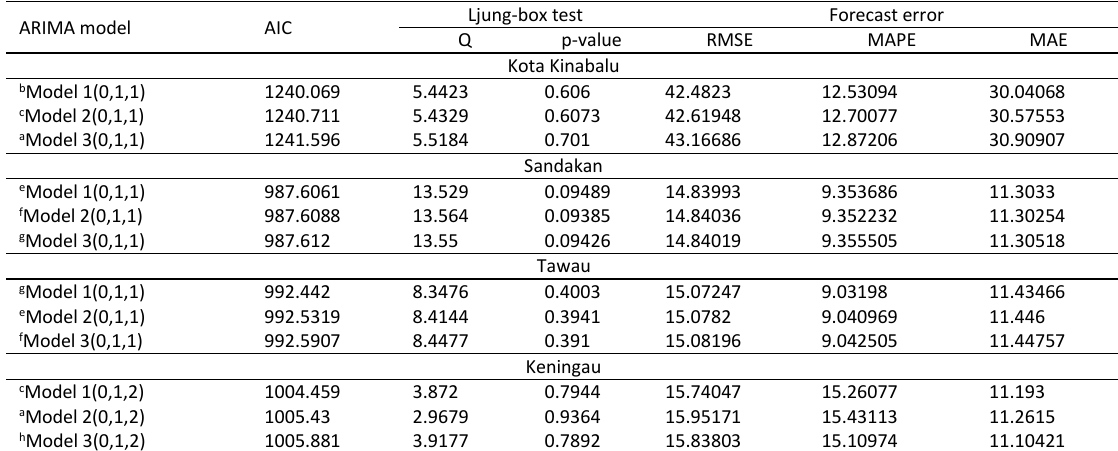
Table 4: ARIMA model for cardiovascular hospital admission in Sabah 2010–2019 with air pollutants as the regressor Ljung-box test Forecast error ARIMA model AIC